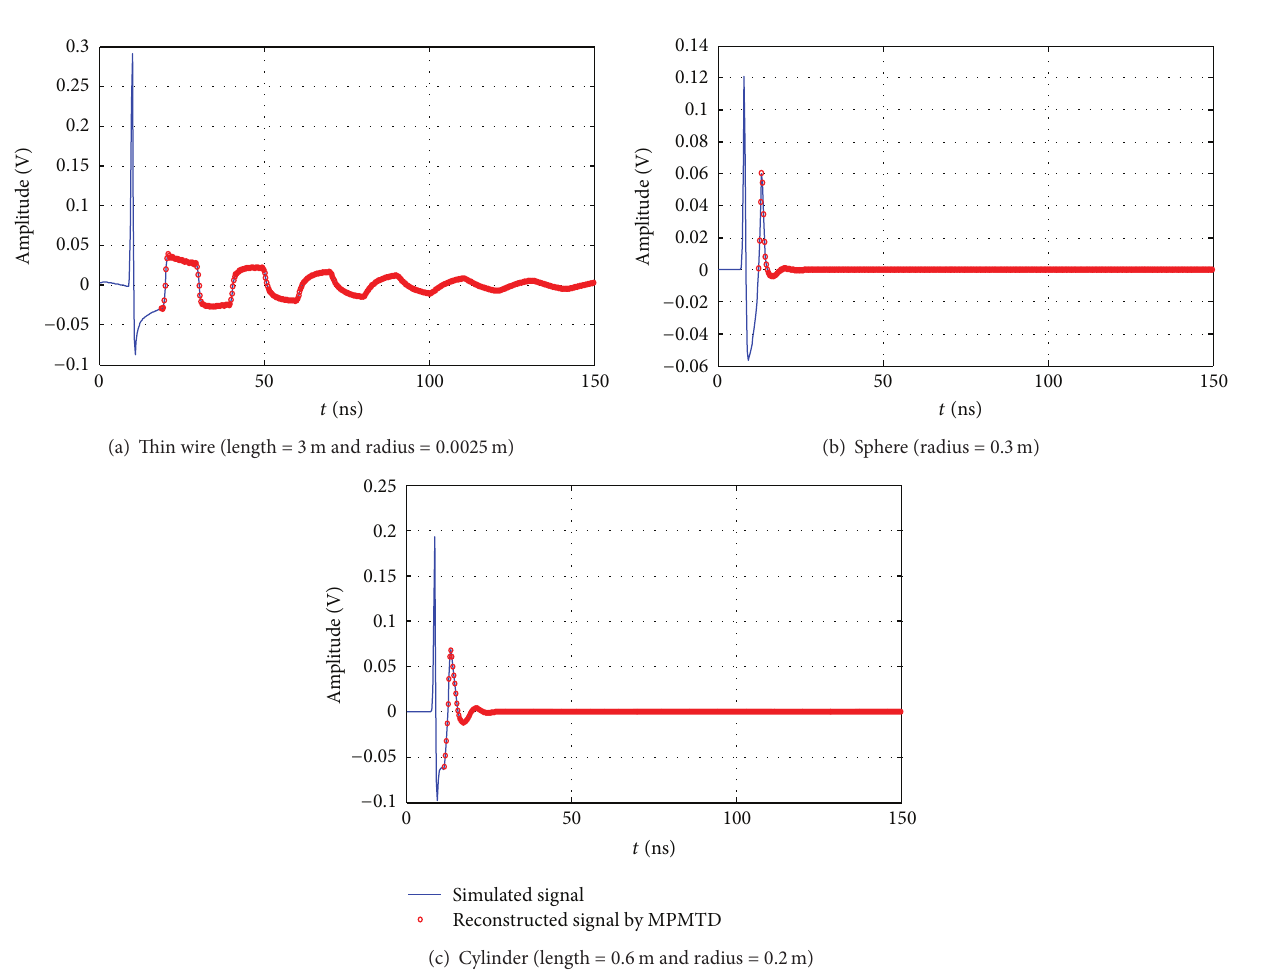
Table 1: Features extracted by MPMTD from a thin wire ( 𝑙 = 3